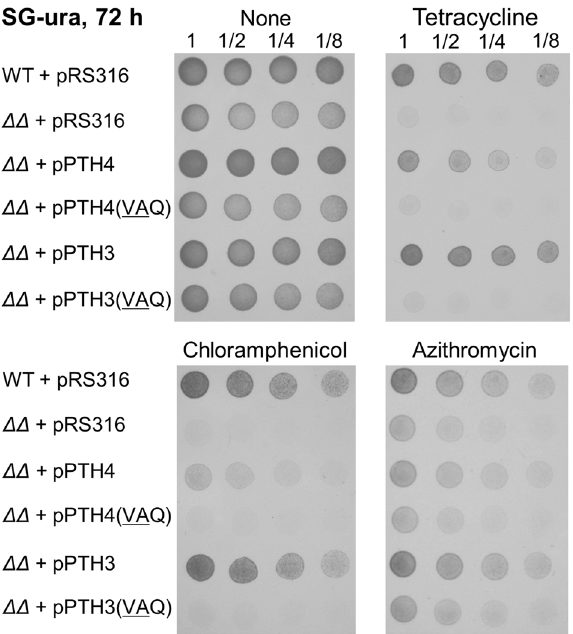
Fig. 2 Suppression of the antibiotic susceptibility phenotype of the double-gene deletion mutant by plasmid-borne PTH3 or PTH4 . The pth4 Δ pth3 Δ mutant (represented by ΔΔ ) was transformed with the plasmid pRS316 harboring a genomic region including PTH4 and PTH3, termed pPTH4 and pPTH3, and the resultant strains were labeled ΔΔ + pPTH4 and ΔΔ + pPTH3, respectively. Each strain was diluted and spotted onto SG-ura plates containing no antibiotic, 100 µ g/mL tetracycline, 1000 µ g/mL chloramphenicol or 75 µ g/mL azithromycin. As a control, pth4 Δ pth3 Δ as well as the wild type was transformed with an empty plasmid, pRS316. In addition, pth4 Δ pth3 Δ was transformed with the plasmid in which the GGQ motif residues were changed to VAQ in pPTH4 and pPTH3, termed pPTH4 (VAQ) and pPTH3(VAQ), respectively. Corresponding images of cells grown on SC-ura plates for 12 h are shown in Supplementary Fig.